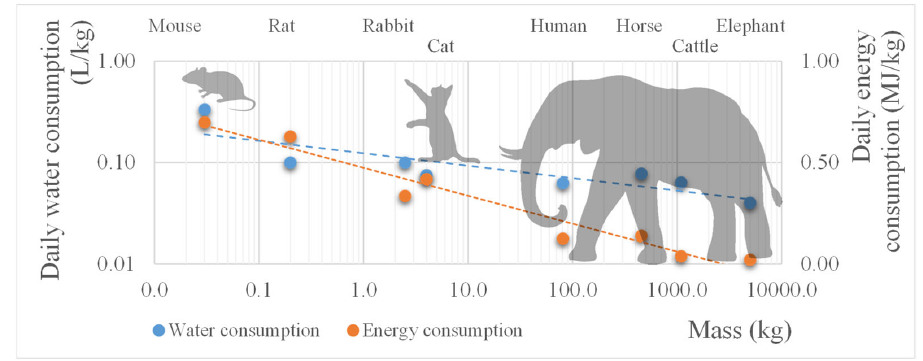
Figure 9. Daily energy and water consumption of mammals (data from [150]).